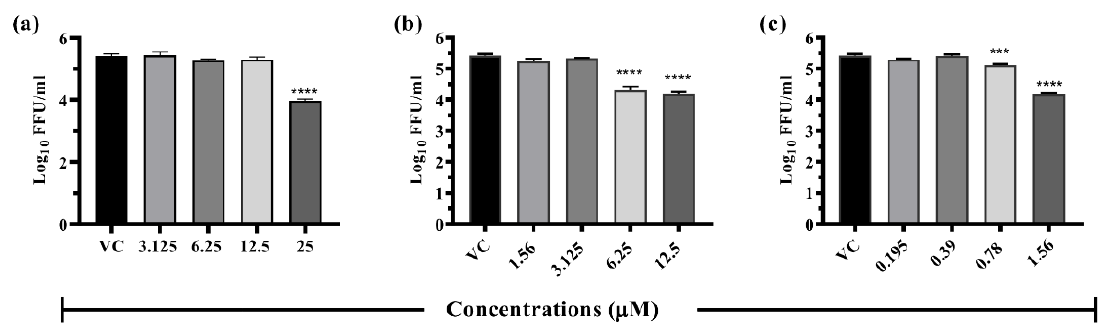
Figure 5. Antiviral effects of doxorubicin, resveratrol, and enalaprilat against DENV under post- treatment conditions. Vero CCL-81 cells were administered the drug at different concentrations immediately after infection and incubated for 120 h after infection. The cultured filtrates were used for the FFU assay: ( a )—doxorubicin, ( b )—resveratrol, and ( c )—enalaprilat. Experiments were performed in triplicate at three independent time points. Results were plotted based on mean log10 of focus-forming unit/mL ± standard error. All the treatment groups were compared with a virus control (VC) group (infected cells which did not receive drugs). **** p < 0.0001, *** p < 0.0005. Resveratrol: Resveratrol at 12.5 µ M and 6.25 µ M concentrations showed ≥ 1 log 10 reduction (5.424 to 4.198 mean log 10 FFU/mL) ( p < 0.0001) of the virus titre compared